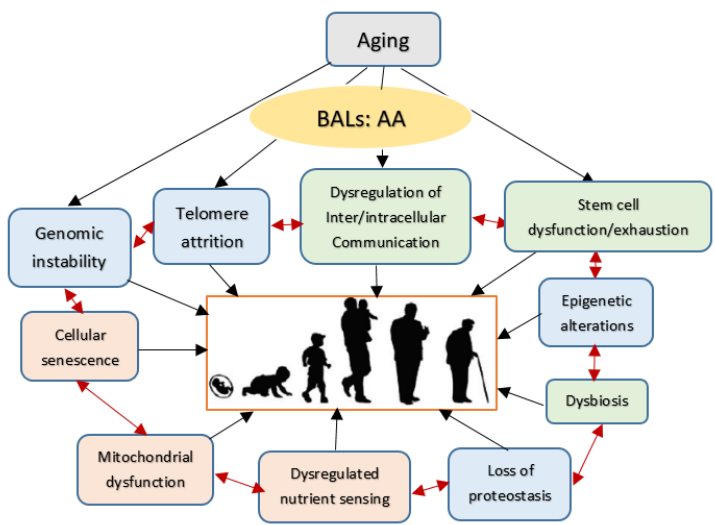
Figure 1. Scheme showing possible changes that can occur during ageing. Changes that are likely to be primary events in the causation of ageing are given in blue; responses to damage are given in orange and hallmarks of the effect of the alterations in genomic stability, telomere attrition and epigenetic changes and loss of proteostasis is given in green. Kindly note that all these events can interact with each other. In all the events associated with aging are modulated by AA (arachidonic acid, 20:4 n − 6) and its